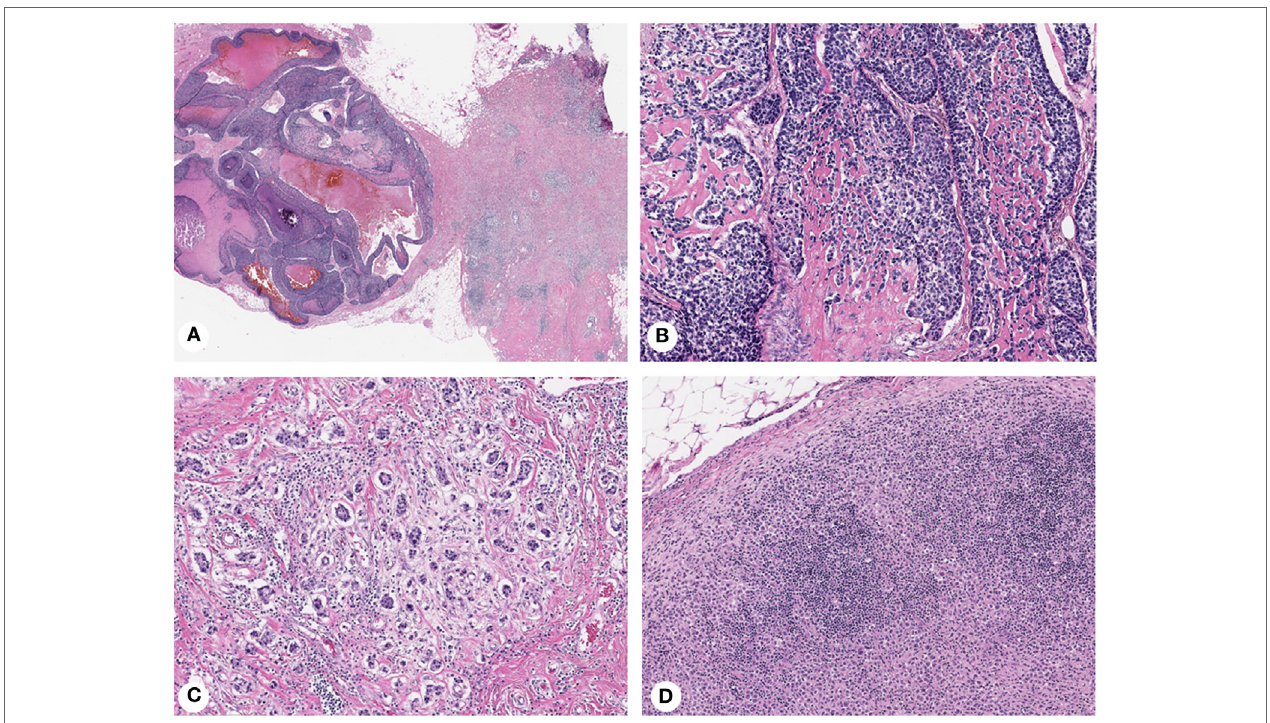
FiGURe 1 | Histopathologic heterogeneity of breast cancer: invasive mammary carcinoma with mixed morphology (A) , composed of basaloid areas with osteoid production (B) and ductal not otherwise specified (C) components. Lymph node metastasis showing a diffuse pattern of tumor growth (D) . Magnification: 100 × (A) , 200 × (B–D) ; Hematoxylin-eosin